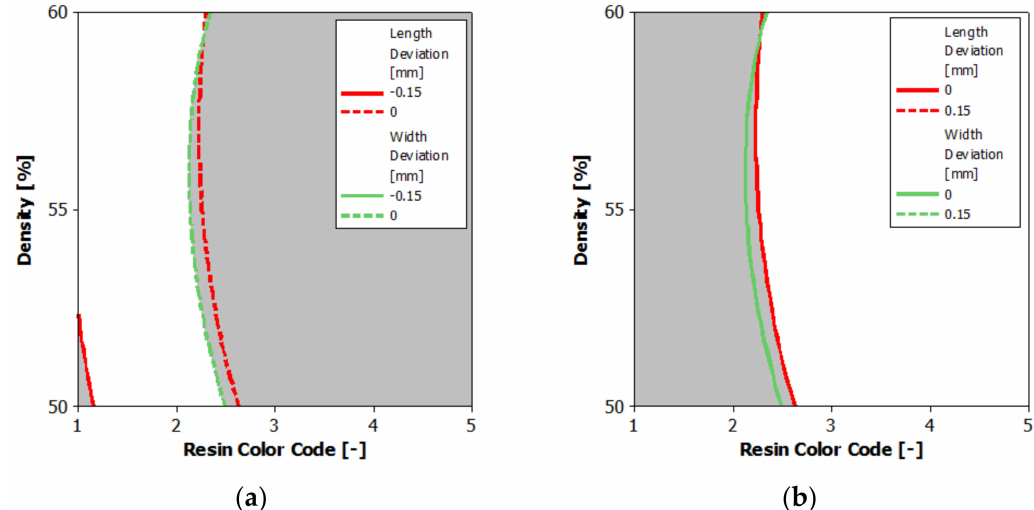
Figure 24. Overlaid contour plot of length deviation and width deviation: ( a ) negative deviations; ( b ) positive